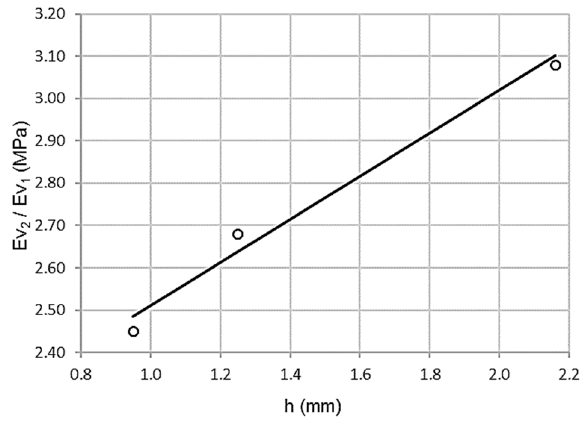
Figure 8. Scatterplot for wheel-tracking test and relation between second and first moduli of the plate bearing test (Ev 2 / Ev 1 ).